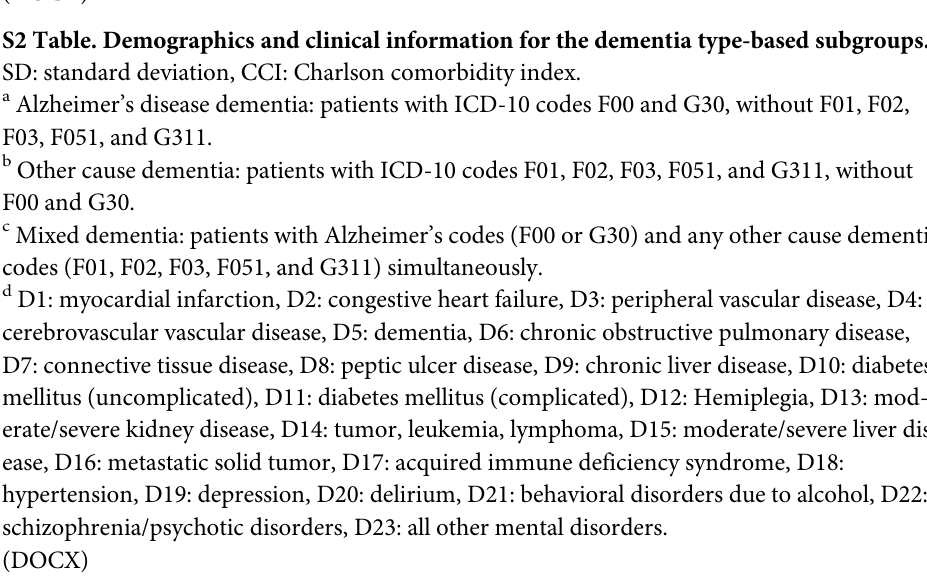
S3 Table. The results of univariate logistic regression analyses according to patient